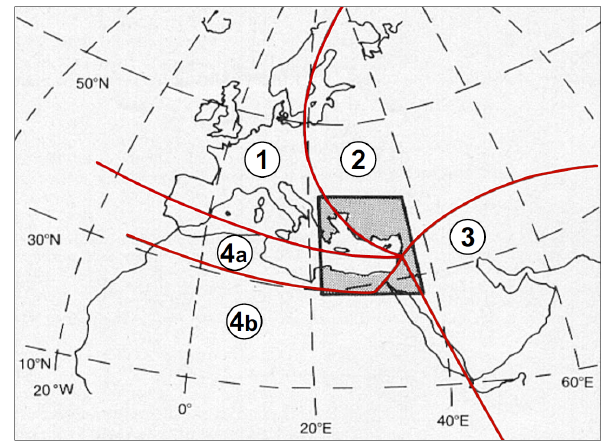
Figure 13. Trajectory typing method used to categorize 5-day back trajectories from the eastern Mediterranean region at 850hPa using the Air Resources Laboratory’s trajectory model (GAMBIT) over the 1978–1982 period (from Dayan, 1986, ©American Meteorolog- ical Society; used with